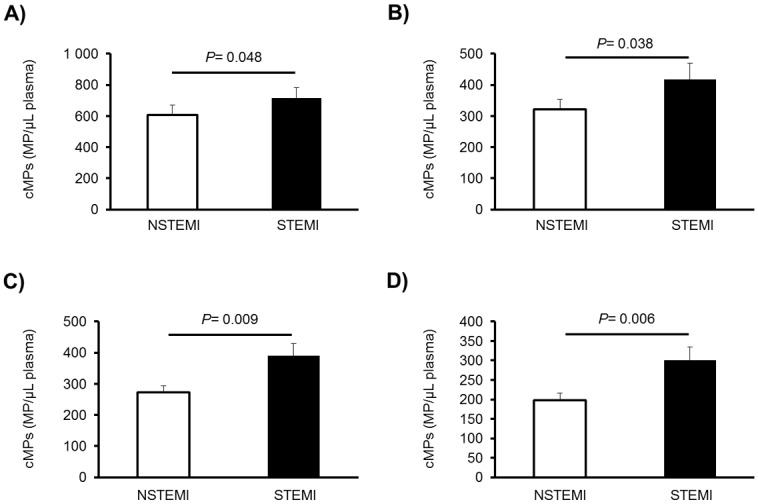
Differences in cMPs between STEMI and NSTEMI patients after 2–8 weeks of suffering an AMI.Results are expressed as mean + SEM. P values from the differences between STEMI (n = 75) and NSTEMI patients (n = 125, one-way ANOVA). cMPS denote circulating microparticles; STEMI, ST-elevation myocardial infarction; PFP, platelet-free plasma; and AV, Annexin V. A) CD61+/AV+ cMPs, where CD61 is a biomarker of platelets; B) CD31+/AV+ cMPs, where CD31 is PECAM (platelet/endothelial cell adhesion molecule 1); C) CD42b+/AV+ cMPs, where CD42b is von Willebrand factor receptor; and D) CD31+/CD42b+/AV+ cMPs, positive for both CD31 and CD42b.